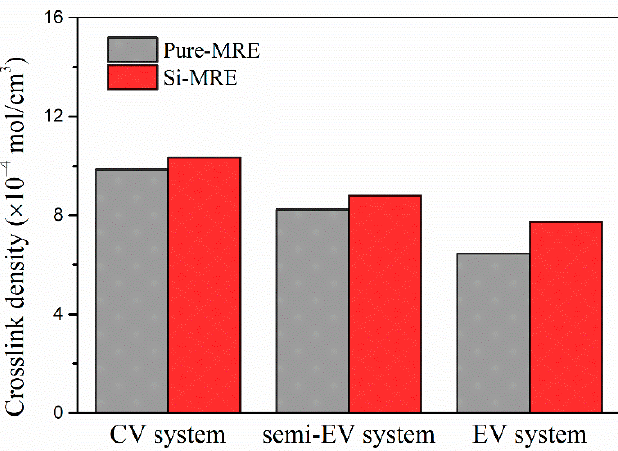
Figure 6. Crosslink density of the MRE and Si-MRE with various vulcanization systems.